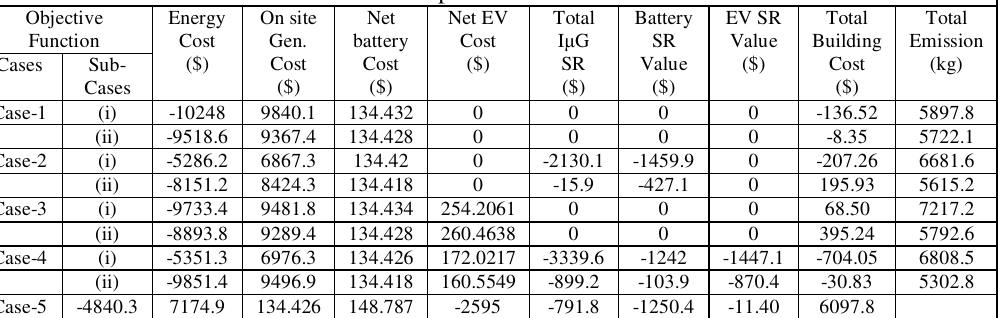
Table 2: Comparison of Case